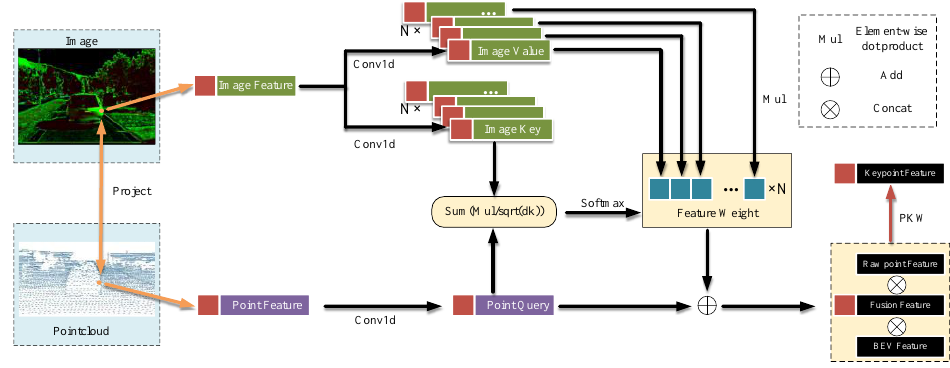
Figure 4. Multimodal Feature Attention (MFA) fusion module.